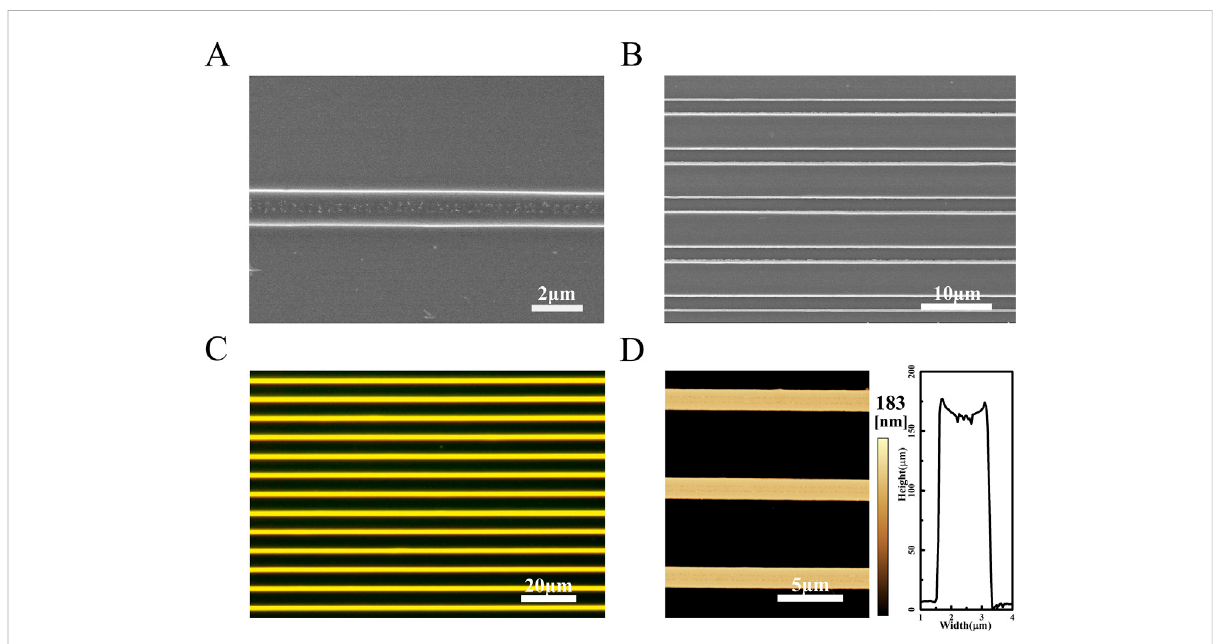
FIGURE 1 (A) SEM image of a single PS/TPMN molecular micro fi lament array. The width of the micro fi laments is 1.41 ± 0.02 µm, and they have fl at and smooth edges (B) Multiple PS/TPMN molecular micro fi lament arrays arrange neatly. The spacing between two adjacent micro fi laments is 5.44 ± 0.11 µm. The micro fi laments are equally spaced and arranged in parallel; (C) Dark- fi eld microscopy photograph of the micro fi lament array with uniform yellow fl uorescence emission from the micro fi laments; (D) AFM photograph of the micro fi lament array and cross-sectional of the micro fi lament array. The micro fi laments are uniform in height with a height of 183